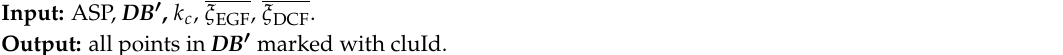
Algorithm 2. ConstructSubTrees(ASP, DB (cid:48) , k c , ξ EGF , ξ DCF )